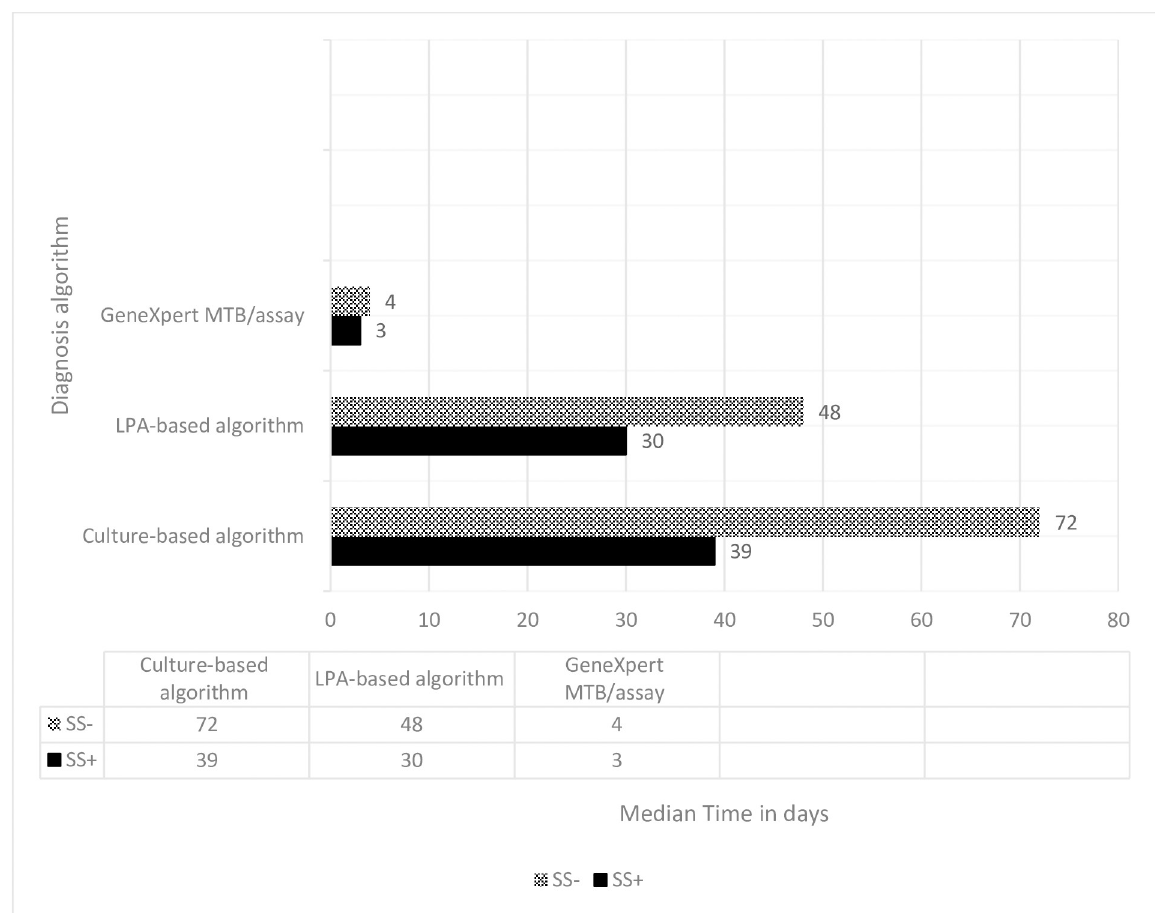
Fig 3. Median time from diagnosis to treatment start for baseline SSm+ and SSm- DR-TB patients diagnosed with different DR-TB diagnostic algorithms.